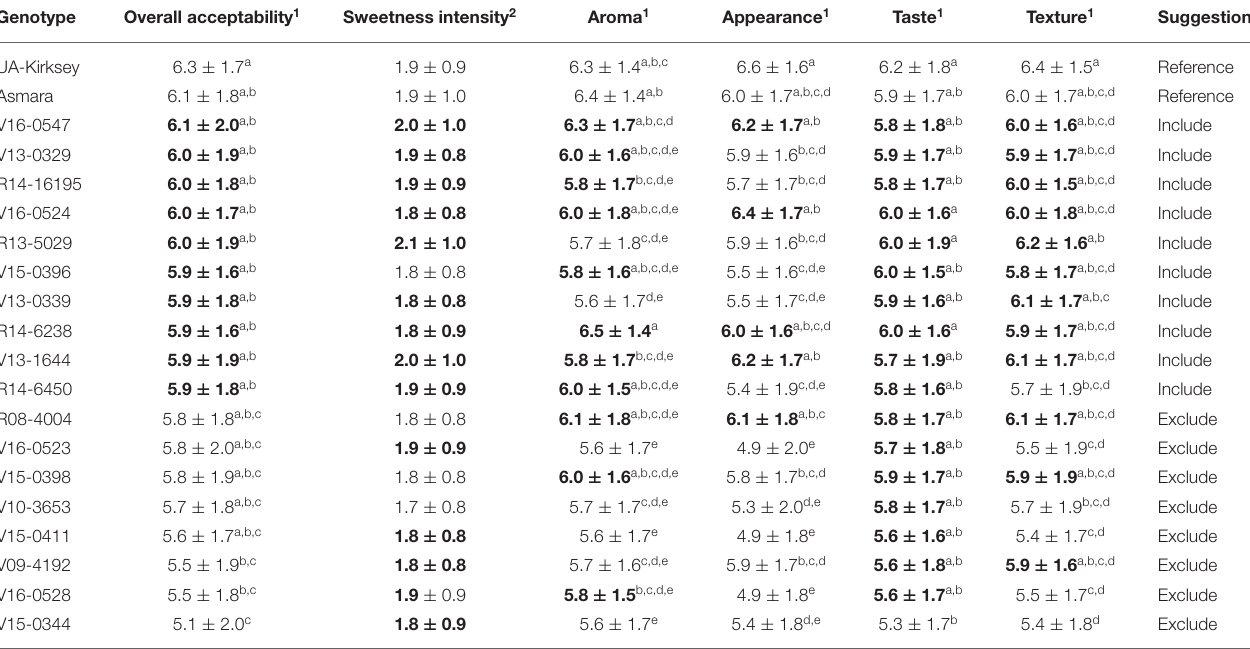
TABLE 3 | Screening Study: Sensory scores (overall acceptability, sweetness intensity, aroma, appearance, taste, and texture) of edamame genotypes for breeding selection.